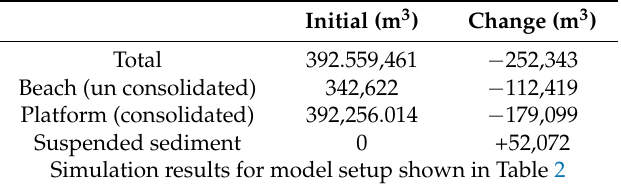
Table 4. Initial and simulated changes of sediment volumes; total, beach and